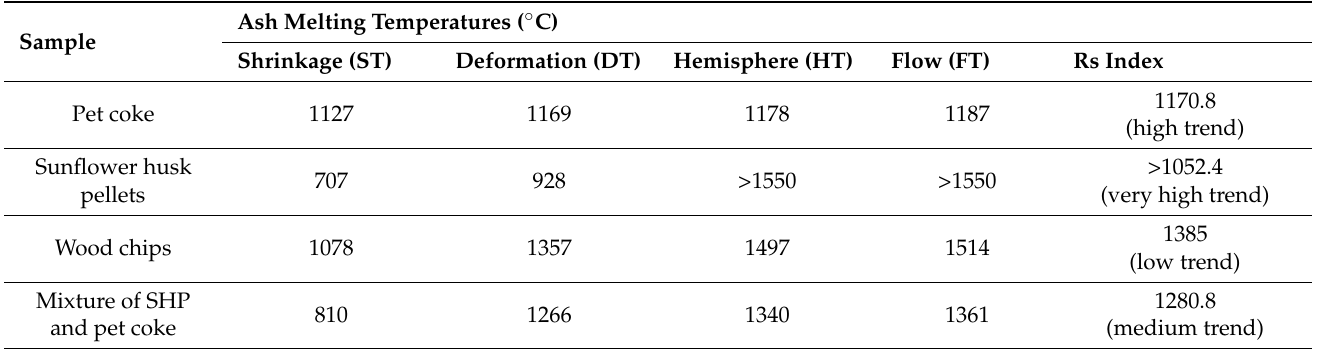
Table 13. Ash melting temperatures and deposit formulation